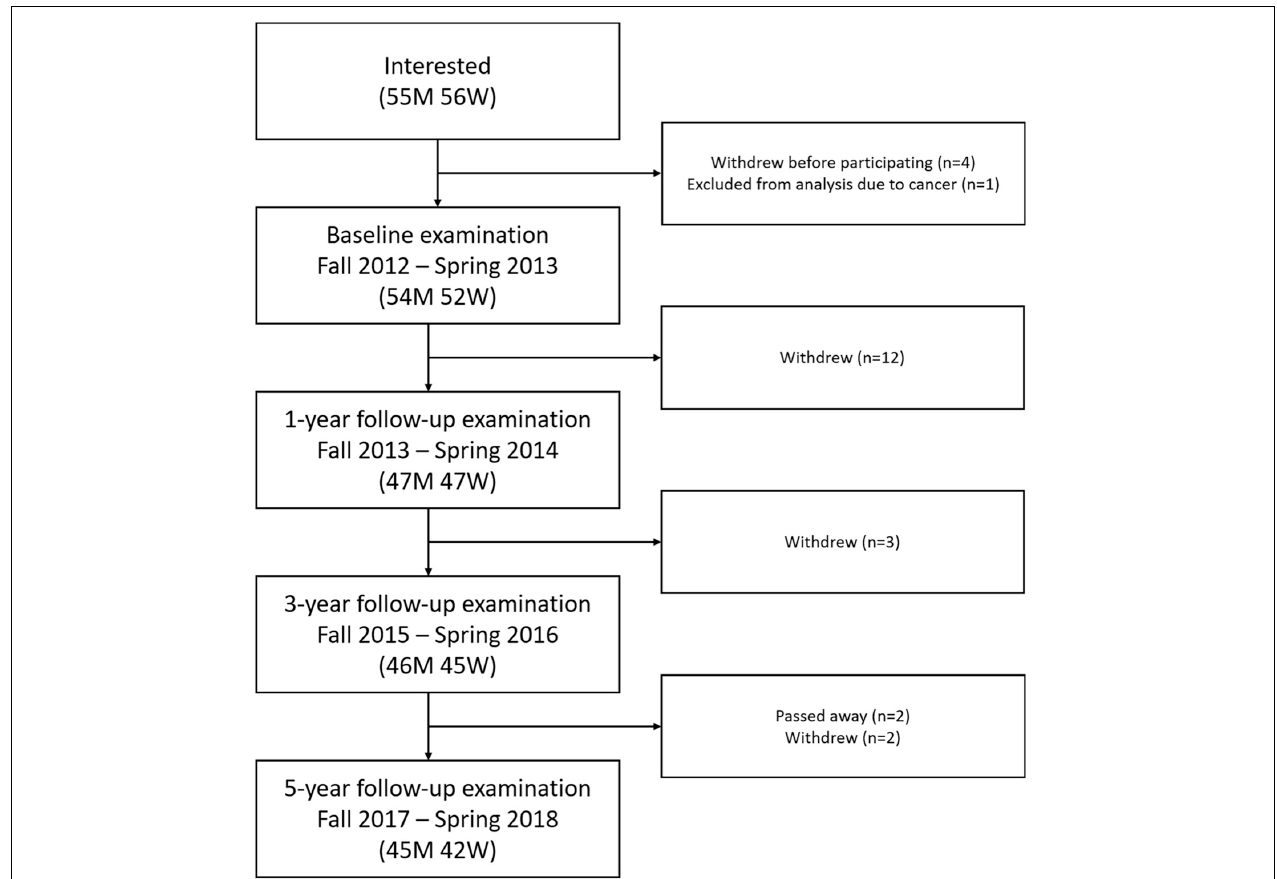
FIGURE 1 | Flowchart of inclusion and attrition. M: men; W: